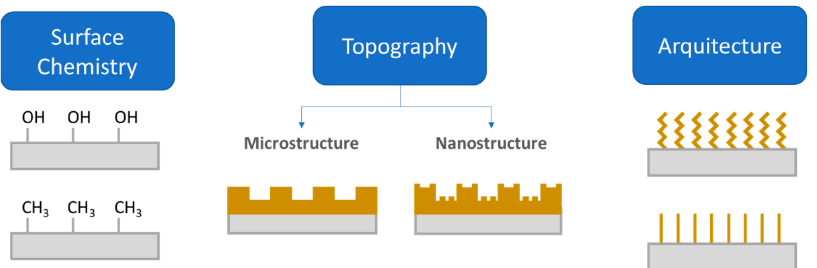
Figure 4. Illustration on three approaches to endow a surface with antifouling properties: (1) modification of surface chemistry; (2) Surface topography; and (3) the architecture of the coating (Figure adapted with permission from Kamperman et al.